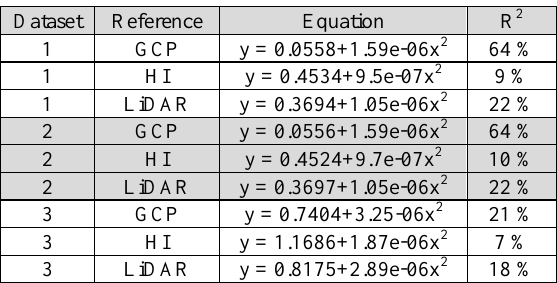
Table 1. Equation of the linear fit and coefficient of determination for the nine different combinations of DEM- and reference datasets. Abbreviations explained in the